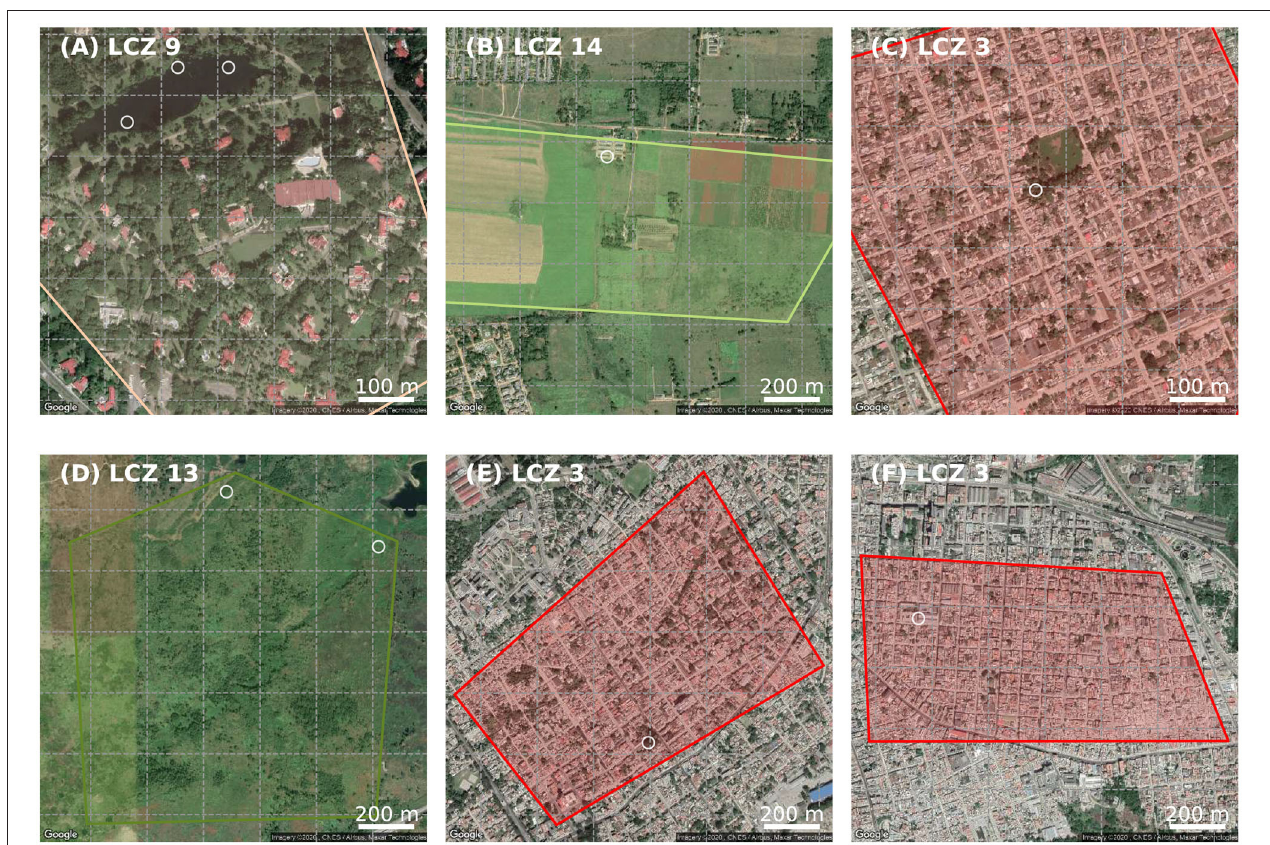
FIGURE 11 | As Figure 8 , but for the third quality control step, for Havana. White circles refer to the centroids of the actual pixels flagged in this quality control